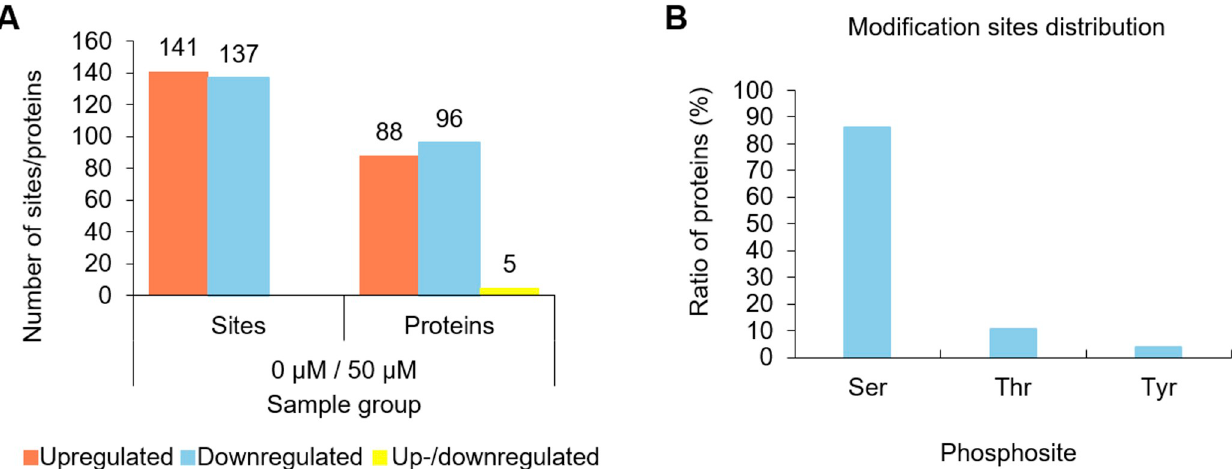
Fig 2. Distribution of phosphorylated proteins and phosphorylated sites. (A) The number of up-, down-, and up-/downregulated phosphorylated sites and proteins in the root of Al 3+ -treated (50 μ M) and untreated (0 μ M) plants. (B) Distribution of phosphorylation sites at serine, threonine and tyrosine residues. Three biological replicates were